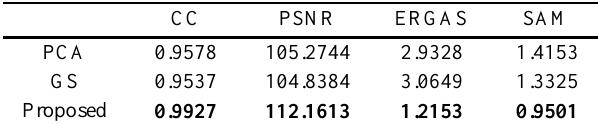
Table 1 The quantitative evaluation